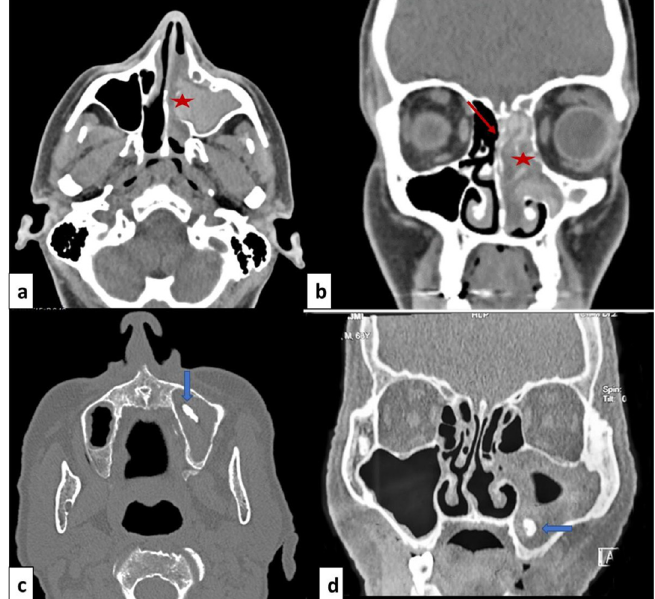
Figure 1. Facial mass computed tomodensitometry with axial cut ( a , c ) and coronal cut ( b , d ). ( a , b ): Allergic fungal rhinosinusitis: heterogeneous opacity of the nasal cavity and ethmoido-maxillary cavities (red star) and thinning of the bony walls (red arrow). ( b , d ): Fungal ball: opacity of the right maxillary sinus with local calcification in maxillary sinus (blue